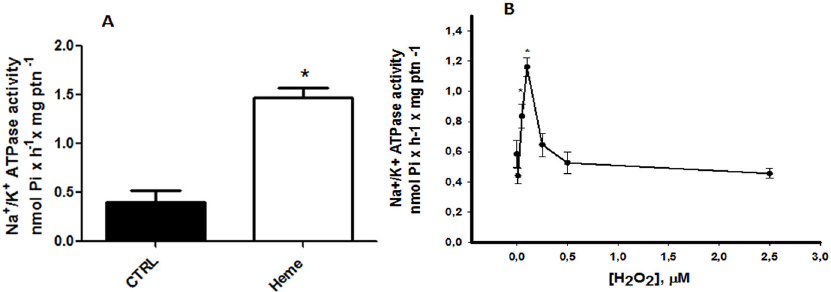
Fig 3. Effect of heme and hydrogen peroxide on the Na + /K + ATPase activity in L . amazonensis . The intact cells were incubated with (white bar) or without (black bar) 2.5 μ M heme (A) or with increasing concentrations of hydrogen peroxide (B) for 20 min. The values represent the mean ± standard error of at least three independent experiments. * Statistically significant when compared to control (P < 0.05). CTRL, control.